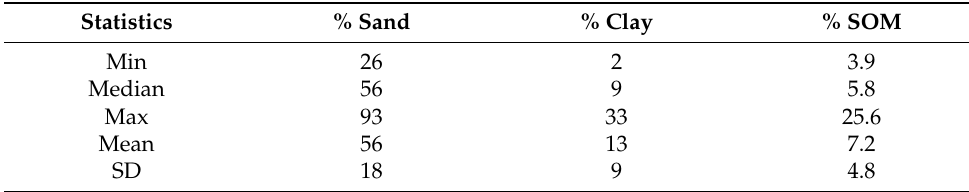
Table 1. Statistical results of the percentages of sand, clay, and SOM content in 19 soils.